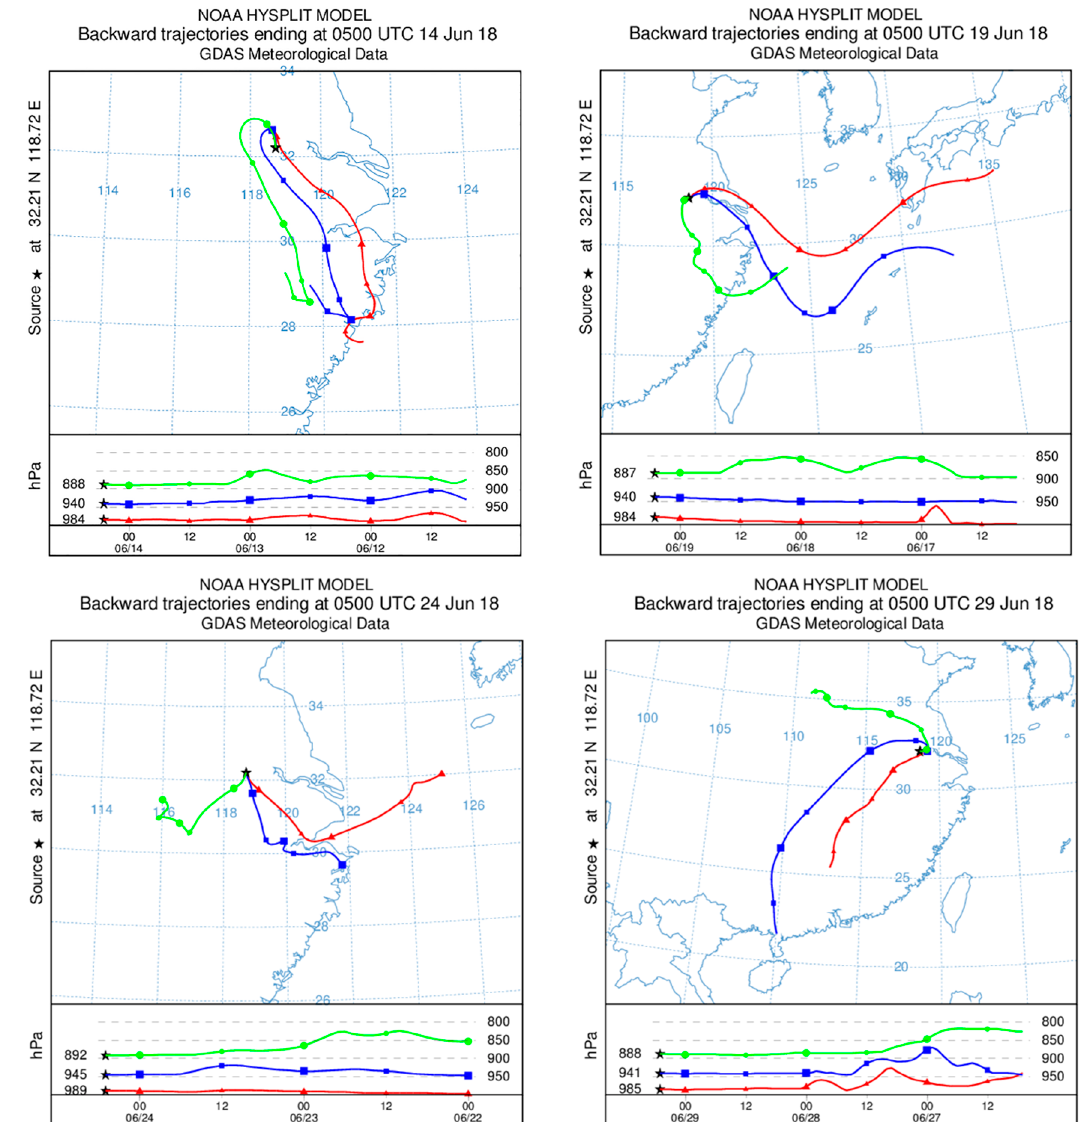
Figure 14. The 72 h HYSPLIT backward trajectory over Nanjing.